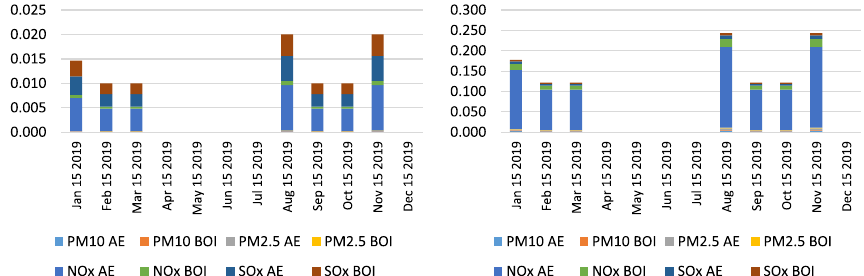
Fig. 11 Health‑related emission calculation of ships at anchorage area of the ports LA&LB based on energy and fuel‑based methodology (left) and Starcrest (right) excluding CO 2 in 2019 (in the average waiting time by months)